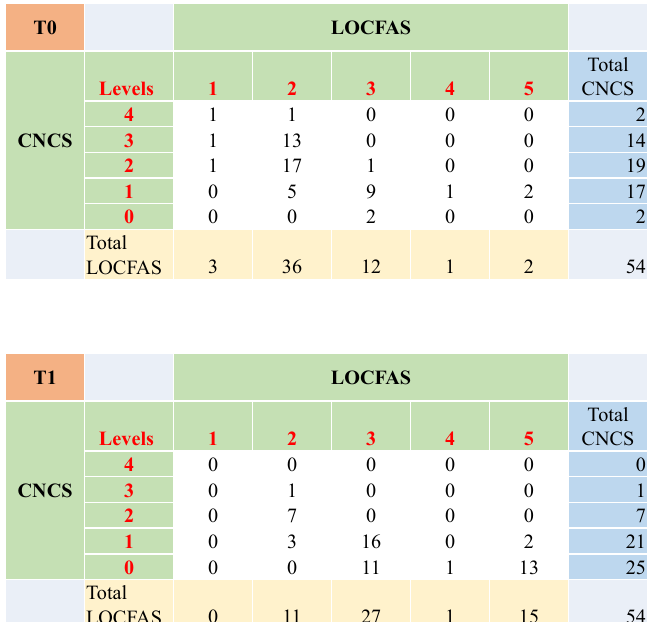
Figure 2. Confusion matrices at three months (T0) and at six months (T1) after injury for patients aged older than 48 months. At T0, patients in CNCS Levels 2 and 3 ‘moderate and marked coma’ were mainly scored at LOCFAS Level 2 ‘generalized response’. Patients in CNCS Level 1 ‘near coma’ were split between LOCFAS Levels 2 and 3 ‘generalized and localized response’. At T1, patients in CNCS 0 scored between 3 and 5 in the LOCFAS (‘localized response’ and above). Total LOCFAS is total number of patients who received a LOCFAS score; Total CNCS is total number of patients who received a CNCS